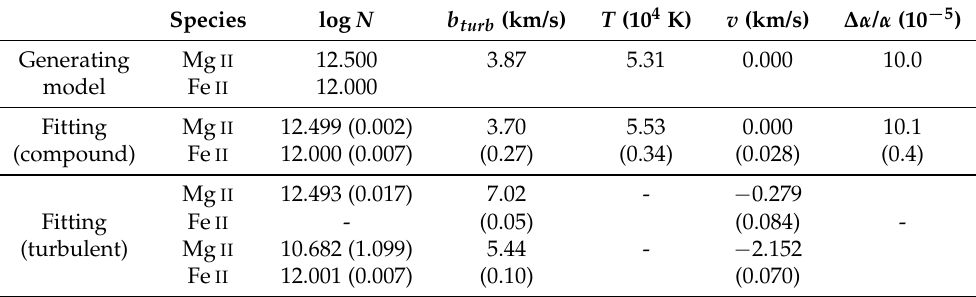
Table 1. Results obtained using VPFIT on a single component simulation. See Section 4.1 for details. v = ( z − z 0 ) c / ( 1 + z 0 ) , where z 0 = 1.1469691 and c is the speed of light. In the lower panel, one of the Fe II components fell below the VPFIT detection limit, indicated in the log N column by “-”. The negative velocities ( v ) for the turbulent case are a consequence of forcing ∆ α / α = 0 (the true value is non-zero). Species log N b turb (km/s) v